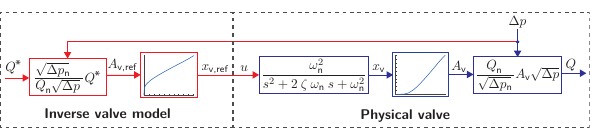
Figure 9: Active gain compensation structure used to obtain the valve voltage